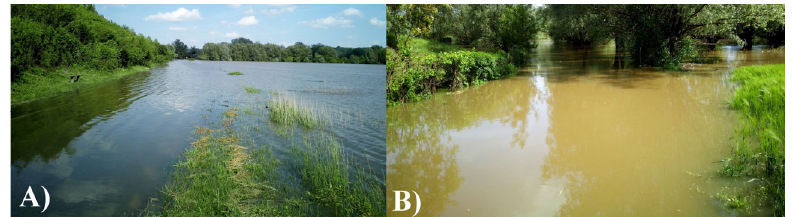
Figure 3. Photos of areas flooded by waters (7 days) from the Vistula River: ( A ) Janowiec; ( B ) Wojszyn (author’s materials, unpublished).